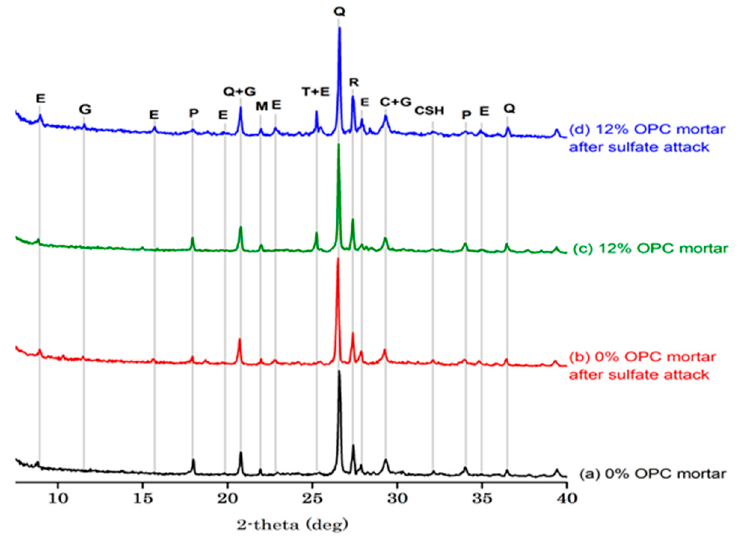
Figure 12. XRD pattern of OPC mortars (E = ettringite, G = gypsum, P = portlandite, Q = quartz, M = monosulfate, T = TiO 2 (anatase), R = rutile, C = calcite, CSH = calcium-silicate-hydrate).